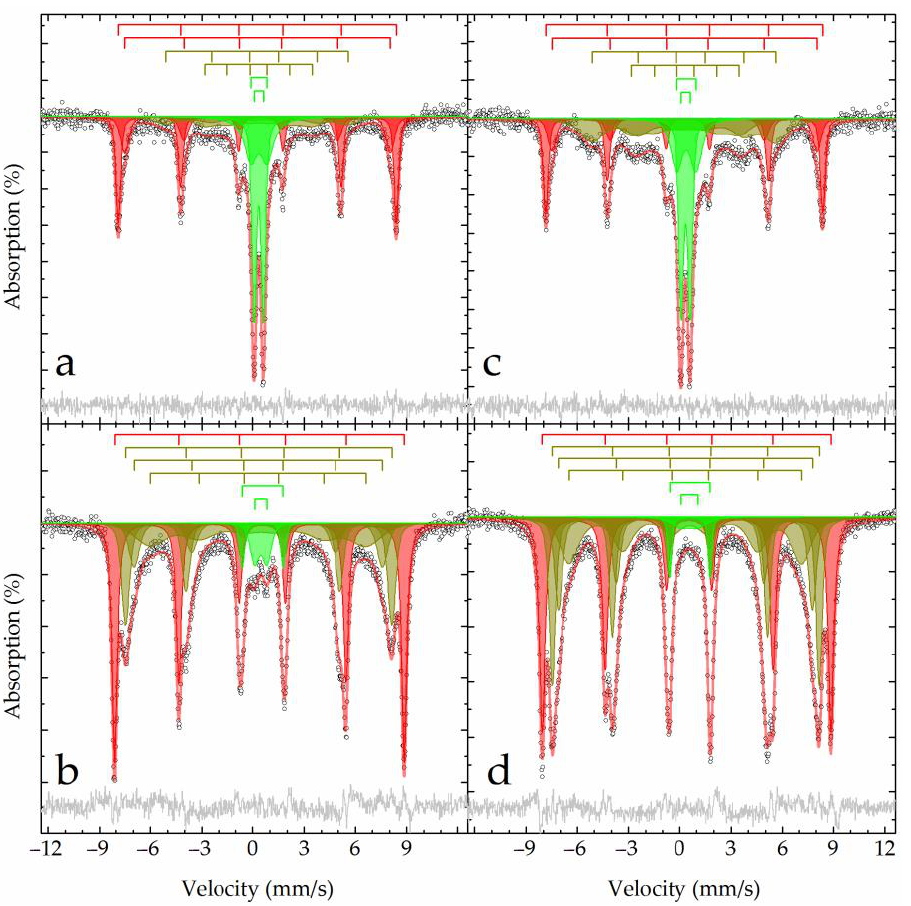
Figure 5. Mössbauer spectra of the BR ( a , b ) and sand ( c , d ) samples obtained at 296 K ( a , c ) and 77.6 K ( b , d ) and their model description according to Table 2.